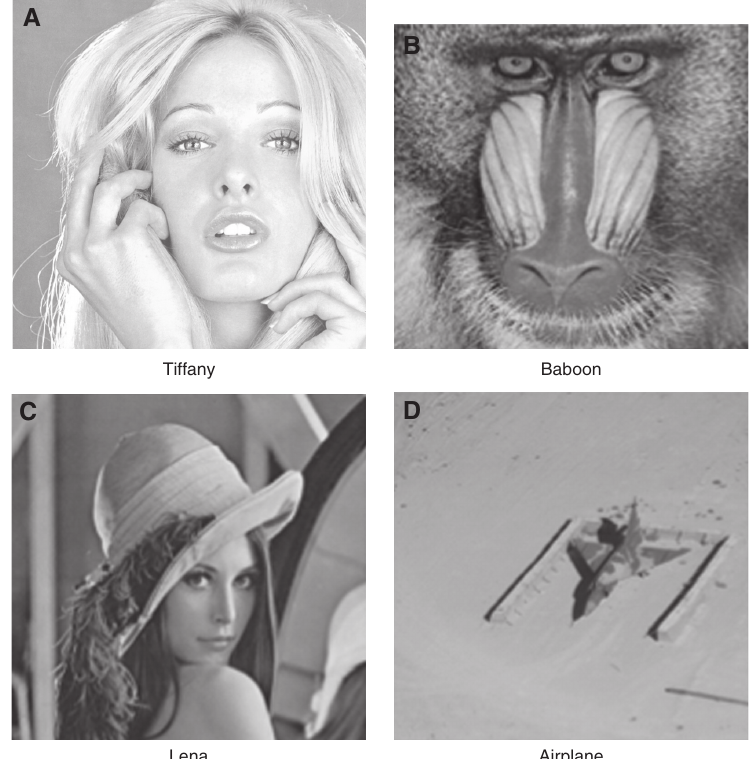
Figure 1. Test Images